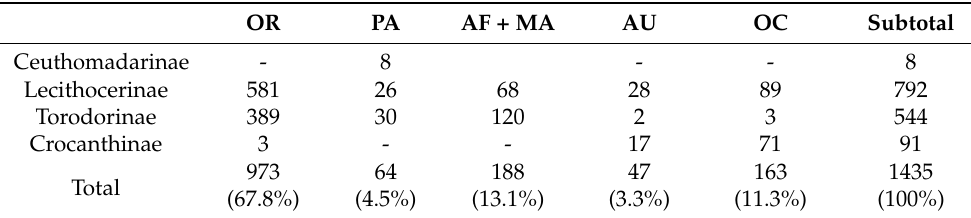
Table 2. Number of species by subfamily and region of the family Lecithoceridae in the world. OR PA AF + MA AU OC Subtotal Ceuthomadarinae - 8